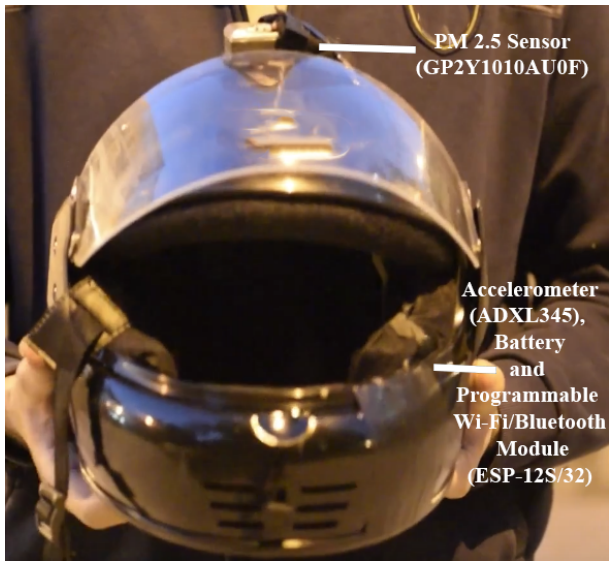
Figure 7. The helmet in its final prototype state. A part of this image is deliberately blurred to avoid intellectual property rights